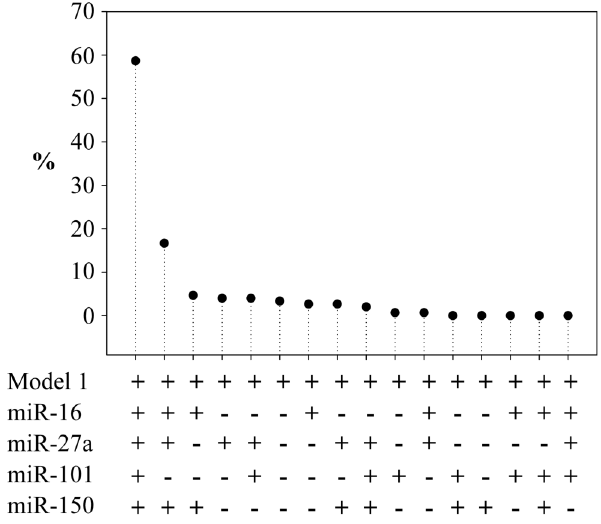
Figure 2. Bootstrap internal validation (logistic regression). Represented is the percentage of times a combination of miRNAs was selected as providing the best improvement of the prediction of model 1 over 150 bootstrap